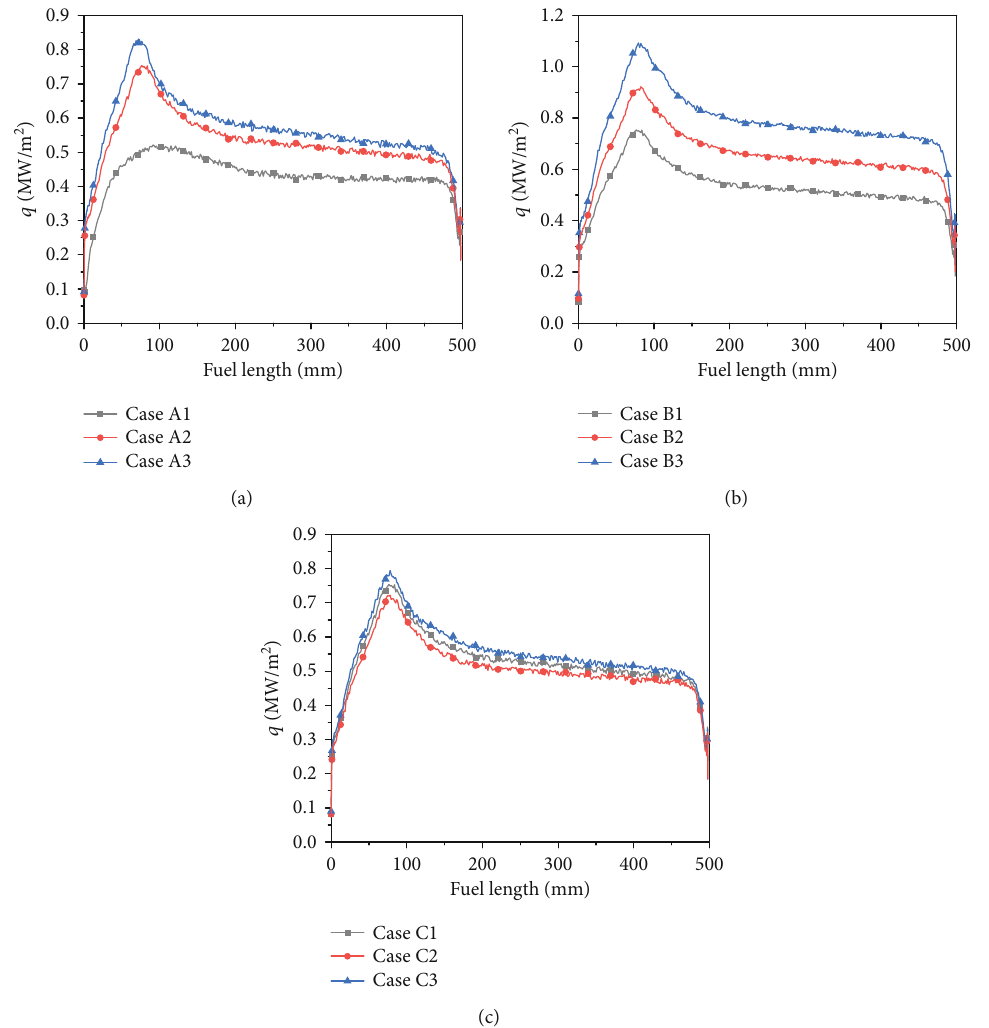
Figure 12: Pro fi les of the local heat fl